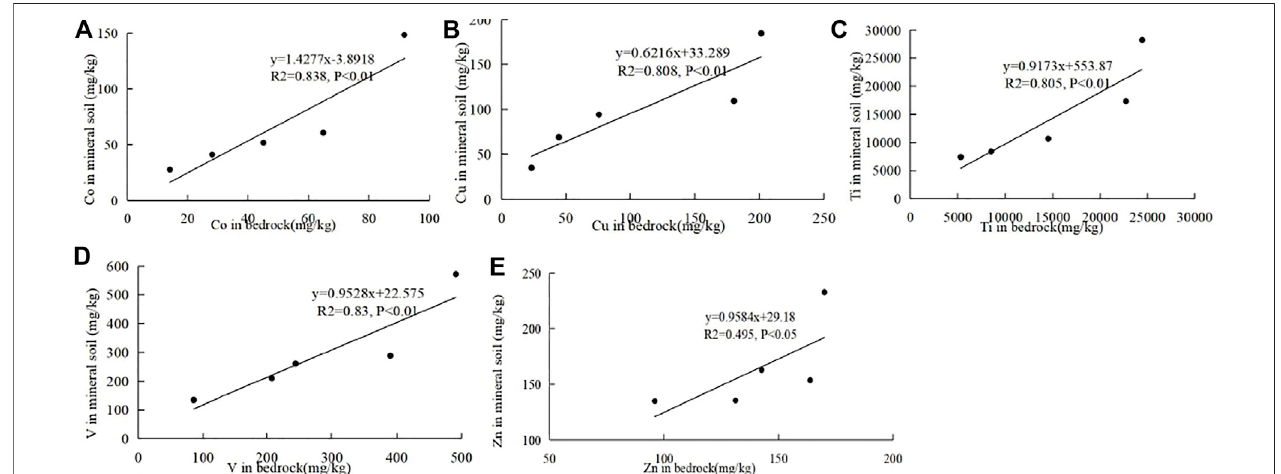
FIGURE 6 | Correlations of Co (A) , Cu (B) , Ti (C) , V (D) , and Zn (E) between the bedrock and soil in the horizon in the non-carbonate area.